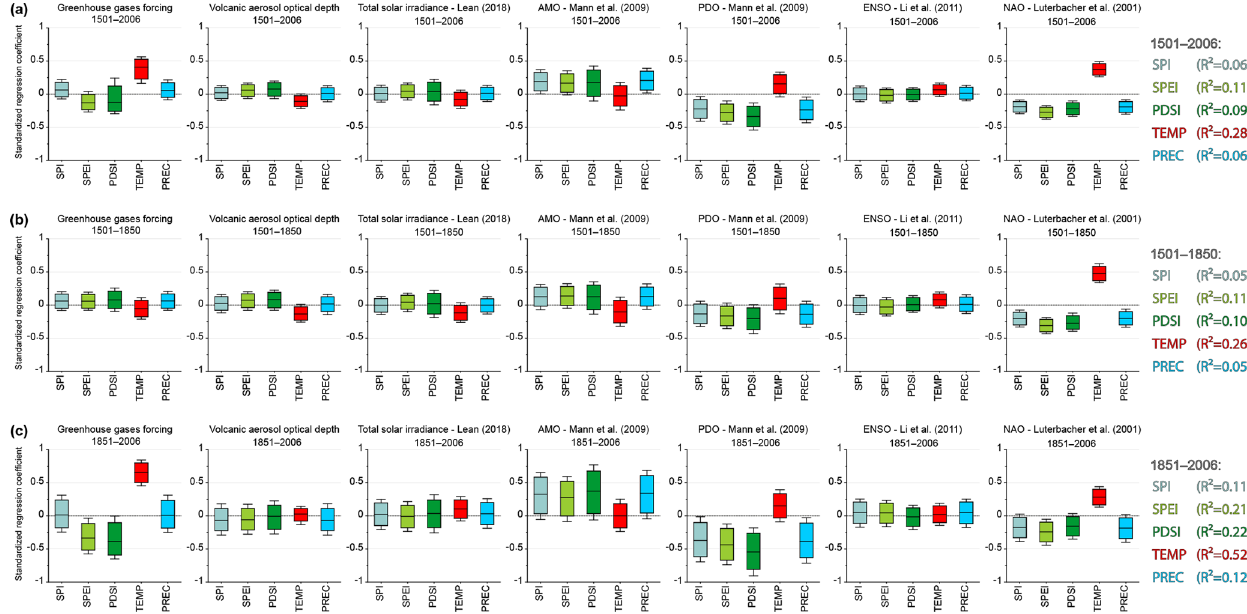
Figure 4. Standardized regression coefficients (central line, with 95% confidence interval shown as the box and 99% confidence interval as the whiskers), obtained by multiple linear regression between the predictands characterizing local Czech climate (drought indices, tempera- ture and precipitation) and a set of explanatory variables representing external forcings and large-scale internal climate variability modes in various periods: (a) 1501–2006, (b) 1501–1850, (c) 1851–2006. R 2 : fraction of variance explained by the regression